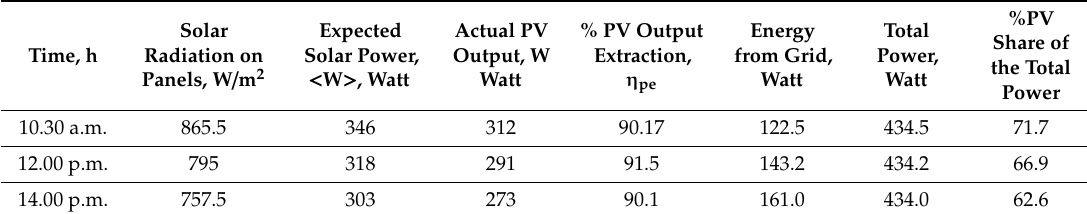
Table 3. Experimental data of power extraction from the PV and the power sharing with the grid. The voltage at the load end was 131 V DC and a hotplate was used as the